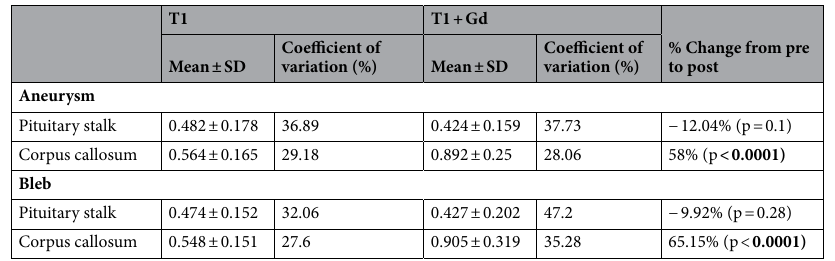
Table 2. Distribution of enhancement ratios of the PS and CC for aneurysms and blebs. Bold values indicate significance less than 0.05.